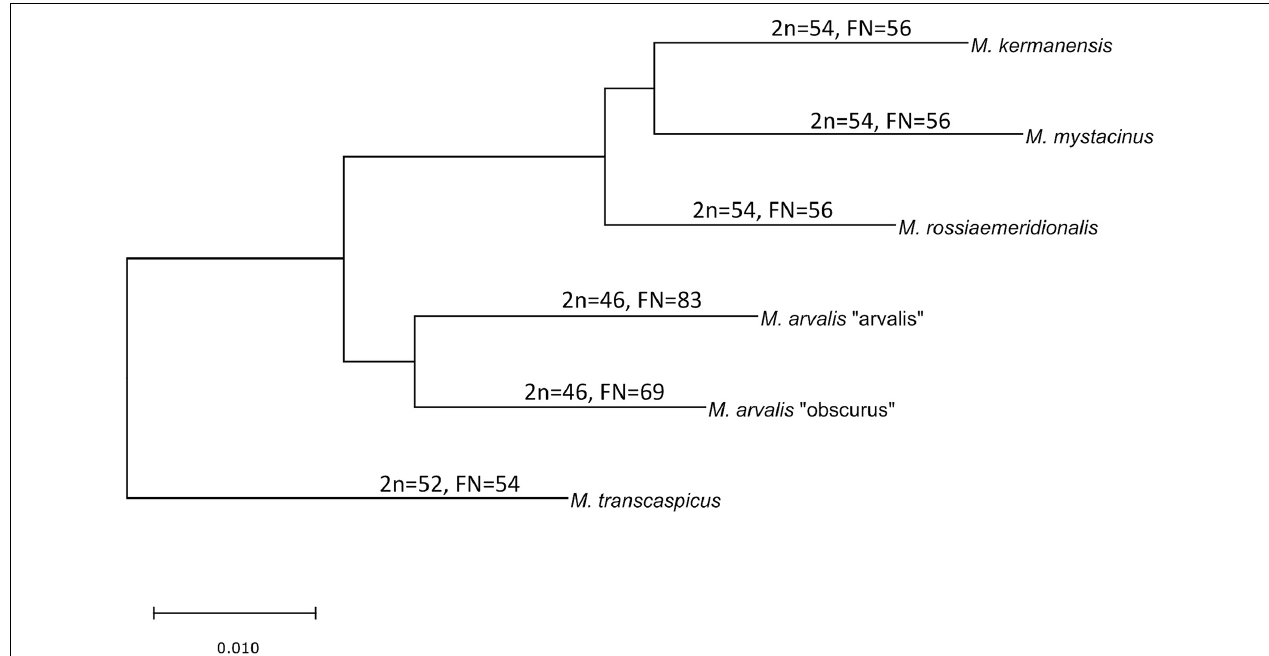
FIGURE 1 | Consensus cladogram of the species of the subgenus Microtus based on Golenishchev et al. (2019).